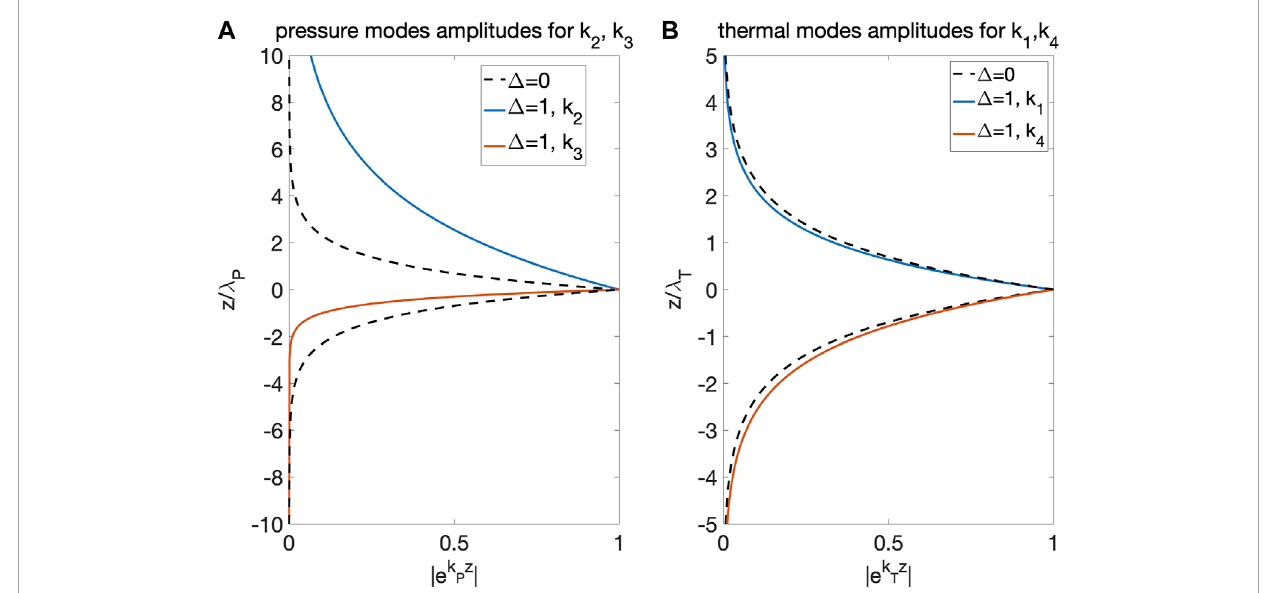
FIGURE 3 Amplitudes of four single submodes e k i z ( i = 1 , 2 , 3 , 4 ) determined by the dispersion relation (6) for a single oscillatory frequency. The amplitudes are shown as functions of vertical distance z . For pressure modes (A) , z is normalized by λ P ; For thermal modes (B) , z is normalized by λ T . The wavenumber k 1 , k 4 deviate from the thermal diffusion endmembers (B) ; the wavenumbers k 2 , k 3 deviate from the poroelastic diffusion endmembers (A) ; k 1 and k 2 determine waves in z > 0 domain (blue curves); k 3 and k 4 determine waves in lower domain (red curves). For Δ = 0, the wavenumbers recover the thermal and poroelastic diffusion endmember cases which have skin depths λ P and λ T .